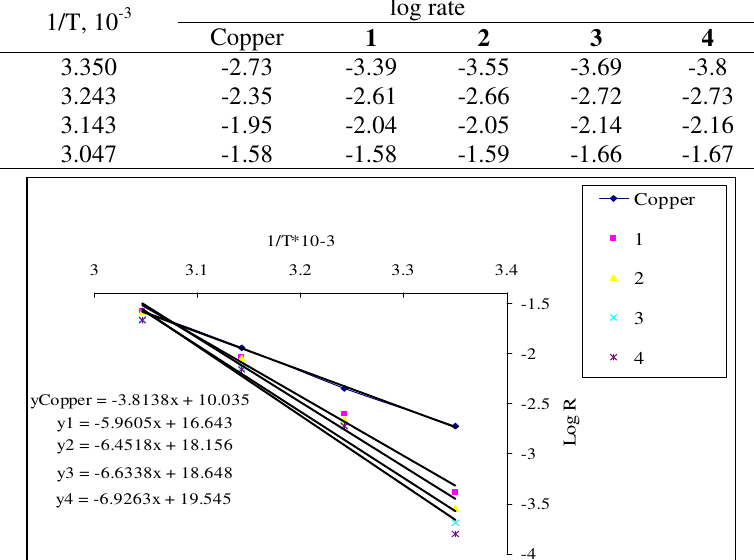
Figure 5. Arrhenius plots of copper in 2 M HNO